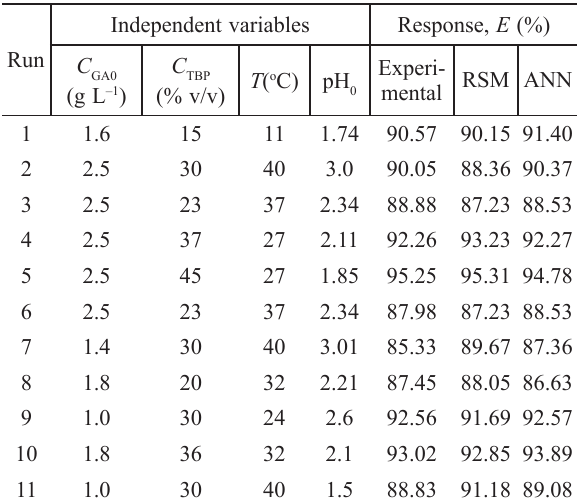
Table 7 – Unseen experimental dataset used in the developed RSM and ANN models for the prediction of ex- traction efficiency of GA